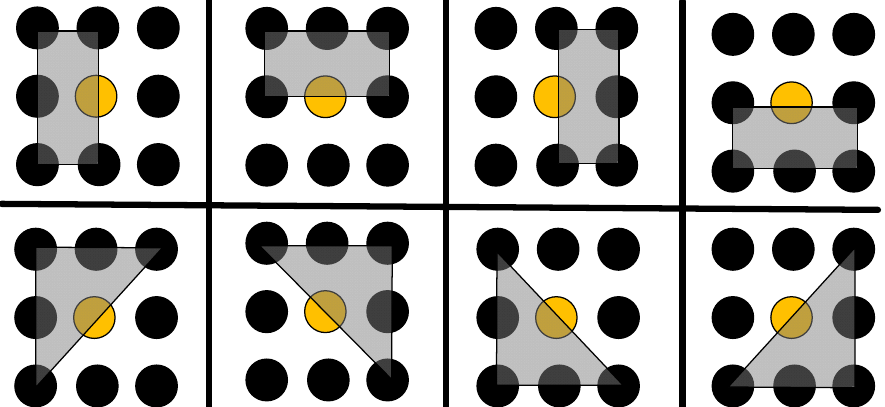
Figure 5. Eight possible normal directions.